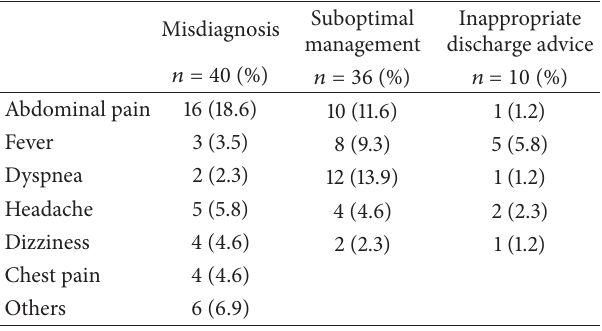
Table 4: Most common chief complaints from physician-related factors, 𝑛 = 86 (%).